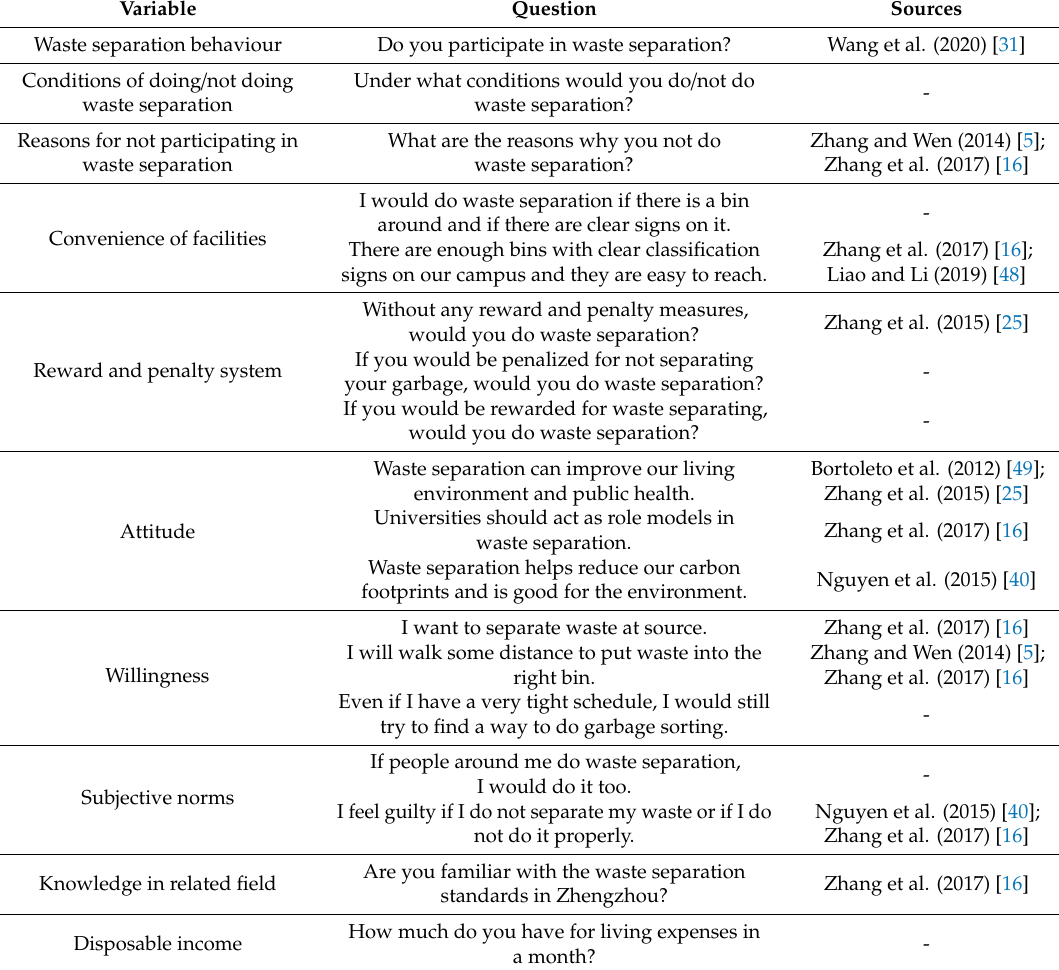
Table 1. Sources of variables and questions in the